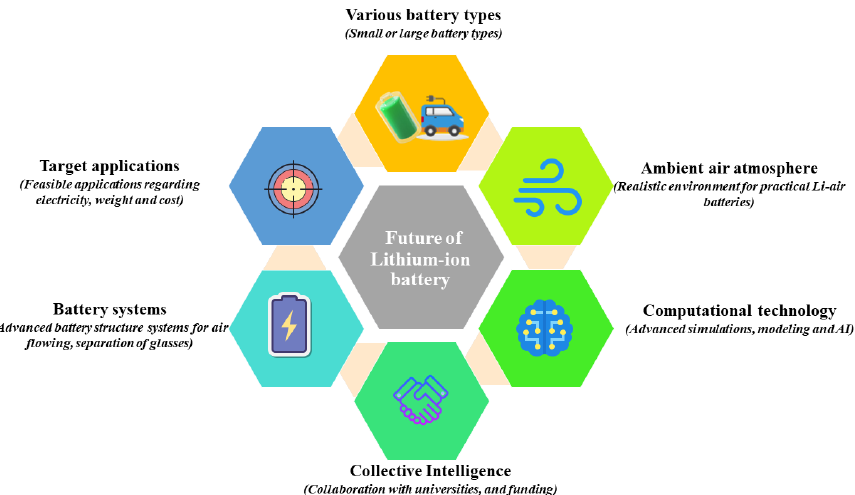
Figure 3. Diagrammatic representation of lithium air batteries.